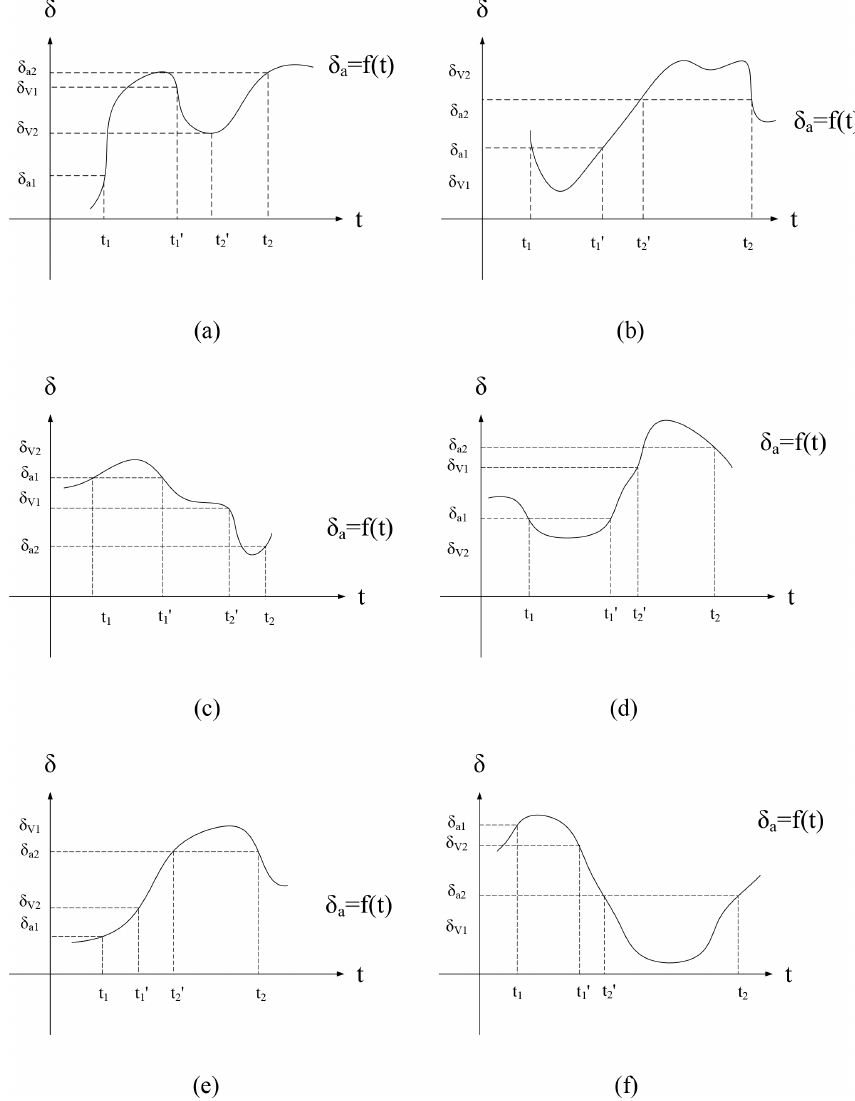
Figure 1. Theoretical diagrams of all possible combinations of the relationships between isotope composition of ambient vapor ( δ a ) and the observed isotope composition of atmospheric vapor ( δ v ) of two continuous moments t 1 and t 2 , ( t 1 < t 2 ). δ a1 and δ a2 represent the δ a value in t 1 and t 2 , respectively. δ v1 and δ v2 represent the δ v value in t 1 and t 2 , respectively. t (cid:48) < t (cid:48) < t 2 . For all of the six situations, there are some subintervals [ t (cid:48) between t 1 and t 2 with t 1 < t (cid:48) 1 2 (cid:3) is within [ min (δ ,t (cid:48) of δ a (t) : t ∈ (cid:2) t (cid:48) v 1 δ v 2 ), max (δ v 1 δ v 2 ) ] 1 2